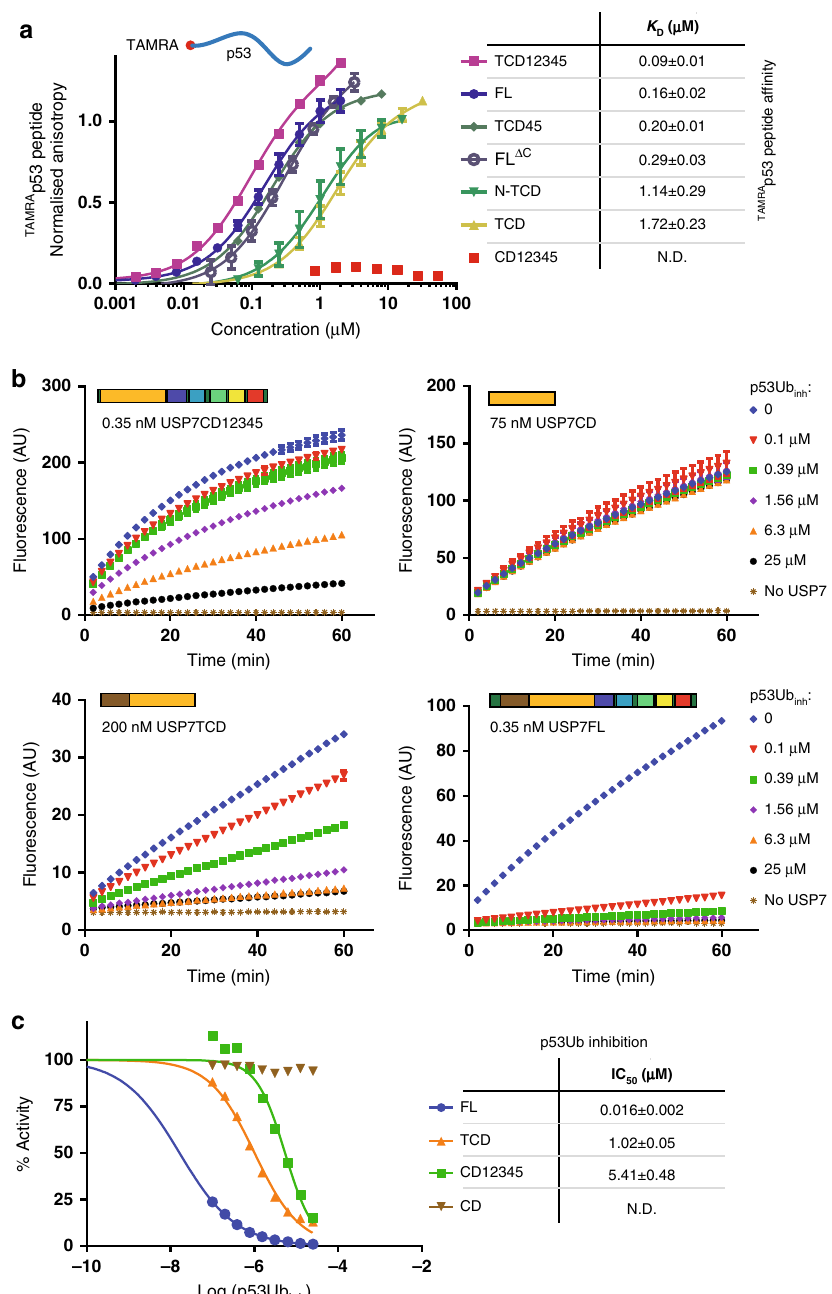
Fig. 5 The p53-derived tools stress the importance of both the TRAF and Ubl45 domain. a Binding of the TAMRA-labelled p53 peptide is determined by incubating 25 nM of TAMRA p53 with a dilution series of various USP7 constructs in FP assays. The obtained K D values for each USP7 construct are stated and indicate that in presence of the TRAF domain, the Ubl12345 domain affects recognition. b The non-hydrolysable p53Ub construct acts as an inhibitor for USP7 in deubiquitination assays. USP7 constructs, corrected for their activity (CD12345: 0.35 nM, TCD: 200 nM, CD: 75 nM, USP7FL: 0.35 nM) were incubated with increasing amounts of p53Ub inh and analysed for activity in a deubiquitination assay using a single concentration of UbRho. The raw data indicate that both the TRAF domain and the C-terminal Ubl domains increase the af fi nity towards the p53 construct. For clarity ’ s sake a limited number of concentrations is shown. c The observed activity for USP7 constructs after incubation with p53Ub inh (see B), is plotted against the concentration of inhibitor used. Fitting yielded IC 50 values and standard deviation as shown. The data points for a , b are the mean ± SD of at least n = 2 experiments. All reported values include the SD